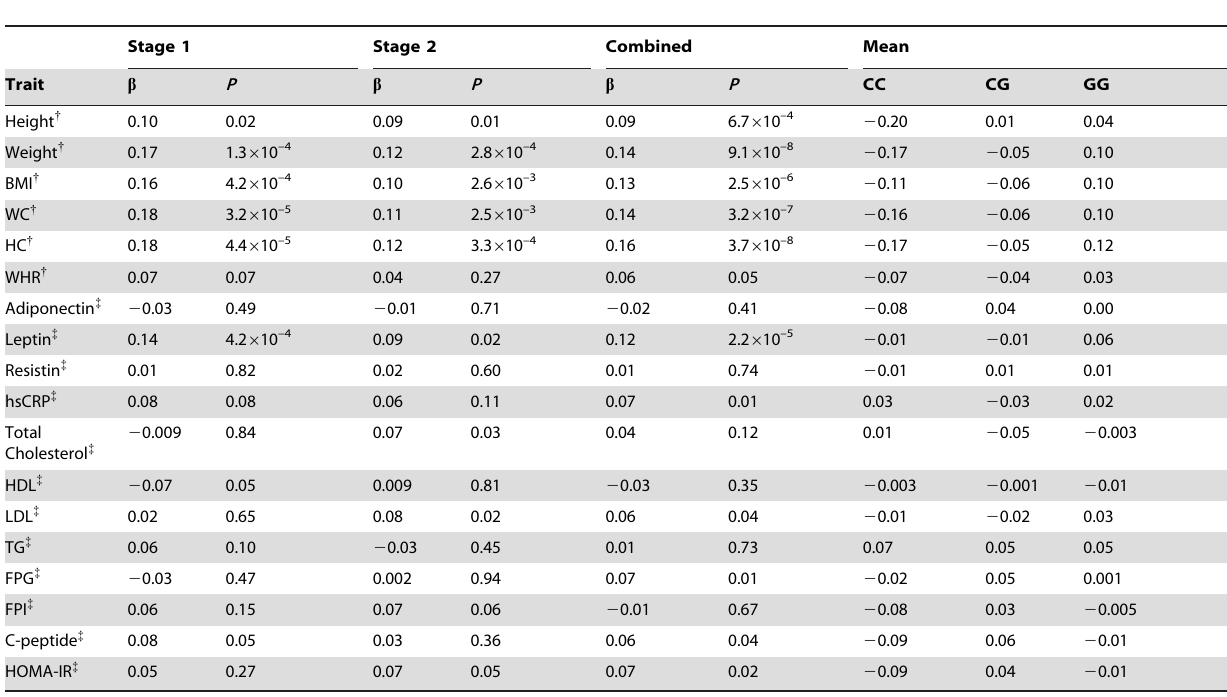
Table 4. Association of AMD1 variant rs2796749 with clinical traits in urban Indian children.